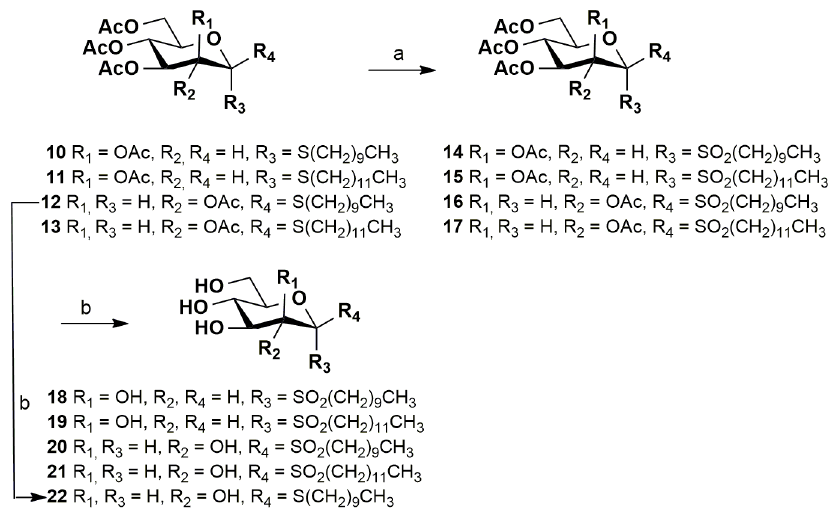
Figure 1. The previously synthesized nonionic glycolipids.